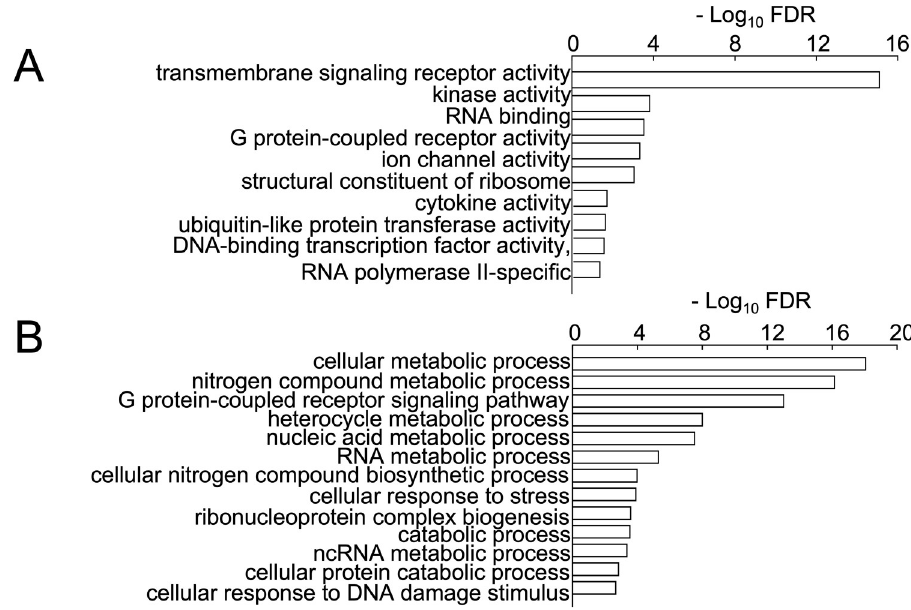
of the false discovery rate